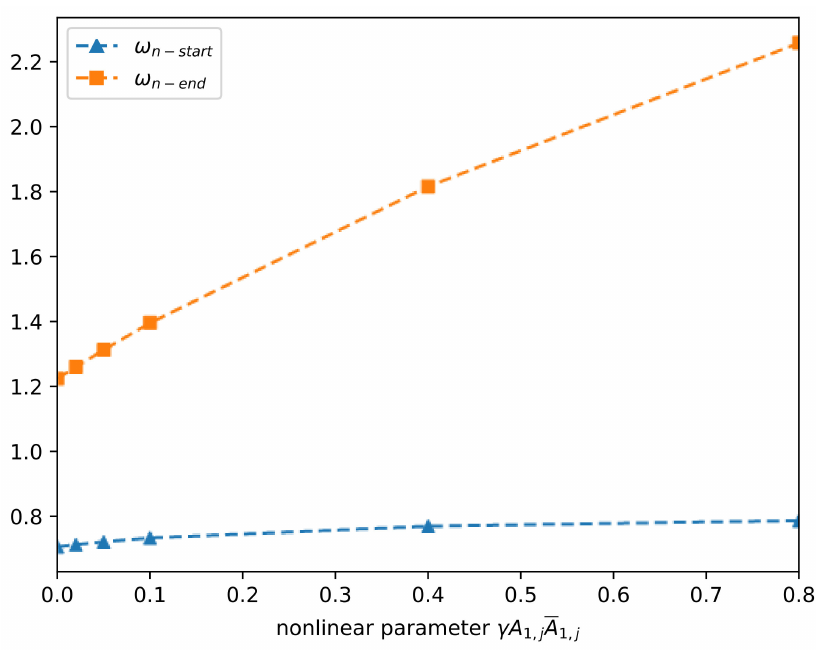
Figure 11. Effect of nonlinear parameter on starting and ending frequencies.